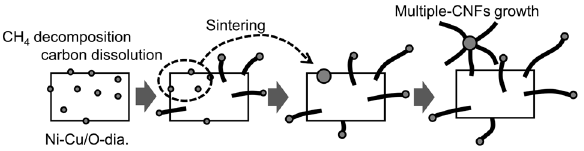
Fig. 10 A model of the multiple-CNFs growth using Ni–Cu/O-dia.